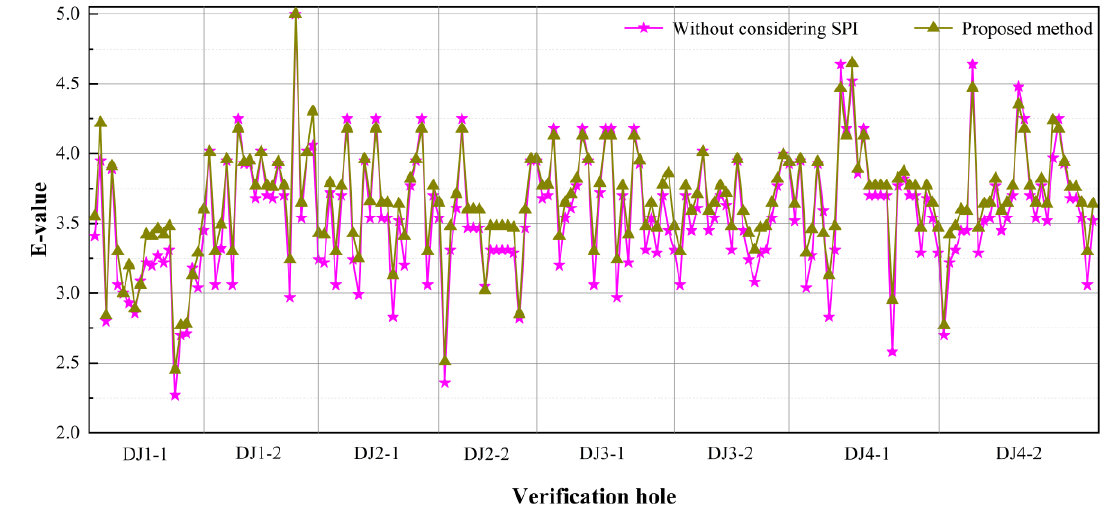
Figure 17. Comparison of the evaluation results by the proposed method and without secondary permeability index (SPI) .